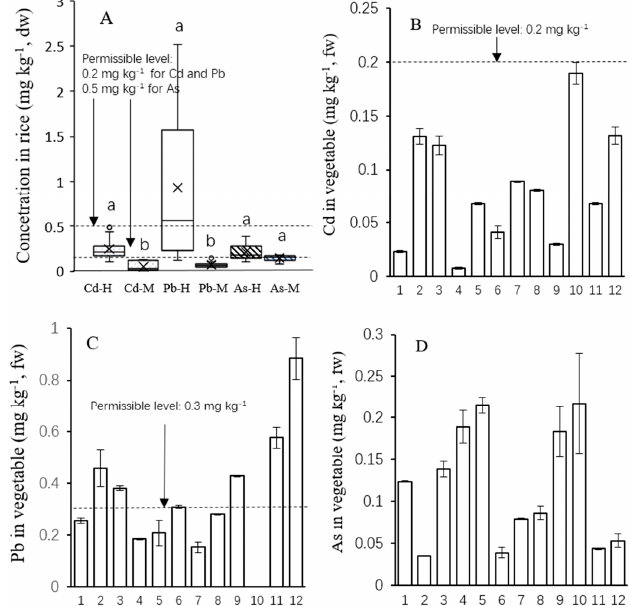
Figure 3. Cadmium, Pb and As concentrations in homegrown rice (H, n = 20) and market rice (M, n = 16) samples collected from study site ( A ), Cd, Pb and As concentrations in vegetable samples ( B – D ), respectivelyl. The vegetables included 1. Hon Tsai Tai ( n = 4); 2. Chinese cabbage peduncle ( n = 3); 3. Asparagus lettuce ( n = 4); 4. Scallion ( n = 3); 5. Edible amaranth ( n = 3); 6. Chinese cabbage ( n = 3); 7. Lettuce ( n = 3); 8. Pak choi ( n = 4); 9. Spinach beet ( n = 3); 10. Spinach ( n = 2); 11. Carrot ( n = 3); 12. Crown Daisy ( n = 3). Boxes represent the 25–75th percentiles. The error bars indicate the standard deviation. Different letters on boxes in ( A ) indicate significant differences ( p < 0.05) between means of home-grown and market-purchased rice.